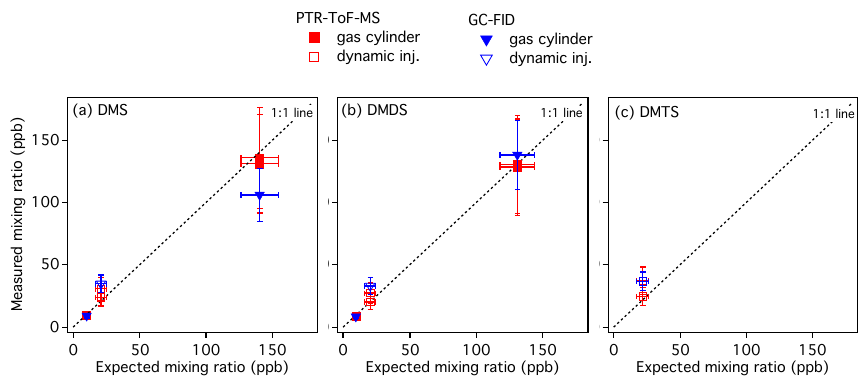
Figure 3. Comparison of quantification of DMS, DMDS, and DMTS using GC-FID (blue markers) and PTR-ToF-MS (red markers). Stan- dards were sampled from either dilutions of a certified gas cylinder (DMS and DMDS; filled symbol) and/or from the dynamic injection system (DMS, DMDS, and DMTS; open symbols). Errors on the mixing ratios measured by the GC-FID method were taken as the 95% confidence interval ( ± 20%) as reported by Simpson et al. (2001) and errors on the mixing ratios measured by the PTR-ToF-MS were taken as ± 30% corresponding to the day-to-day instrument variation. The 1 : 1 line corresponds to the line of perfect agreement between the mix- ing ratios measured by either the PTR-ToF-MS or the GC-FID and the expected value. The errors bars for the expected mixing ratios after dilution were estimated as ± 10% (2 σ) for the DMS/DMDS gas cylinder and as ± 20% (2 σ) for the mixtures from the dynamic injection system, based on error propagation analysis.